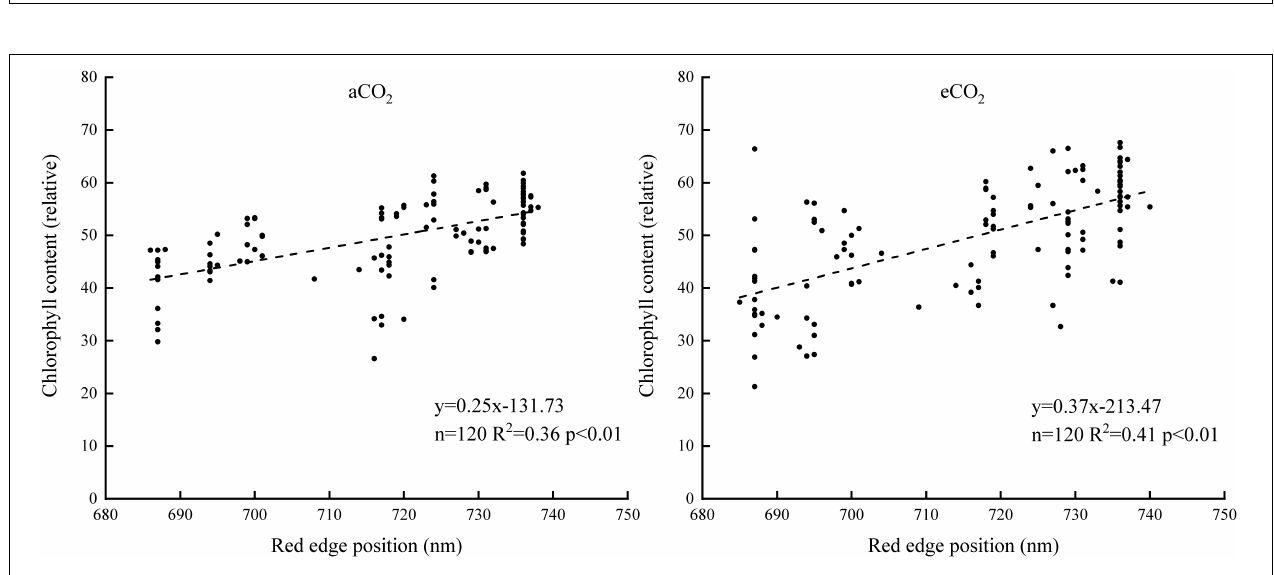
FIGURE 2 | The relationship between the chlorophyll content and the red-edge positions.